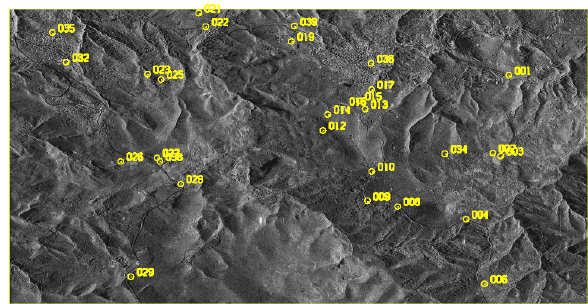
Figure 2. Distribution of the GCPs on the TerraSAR-X image in